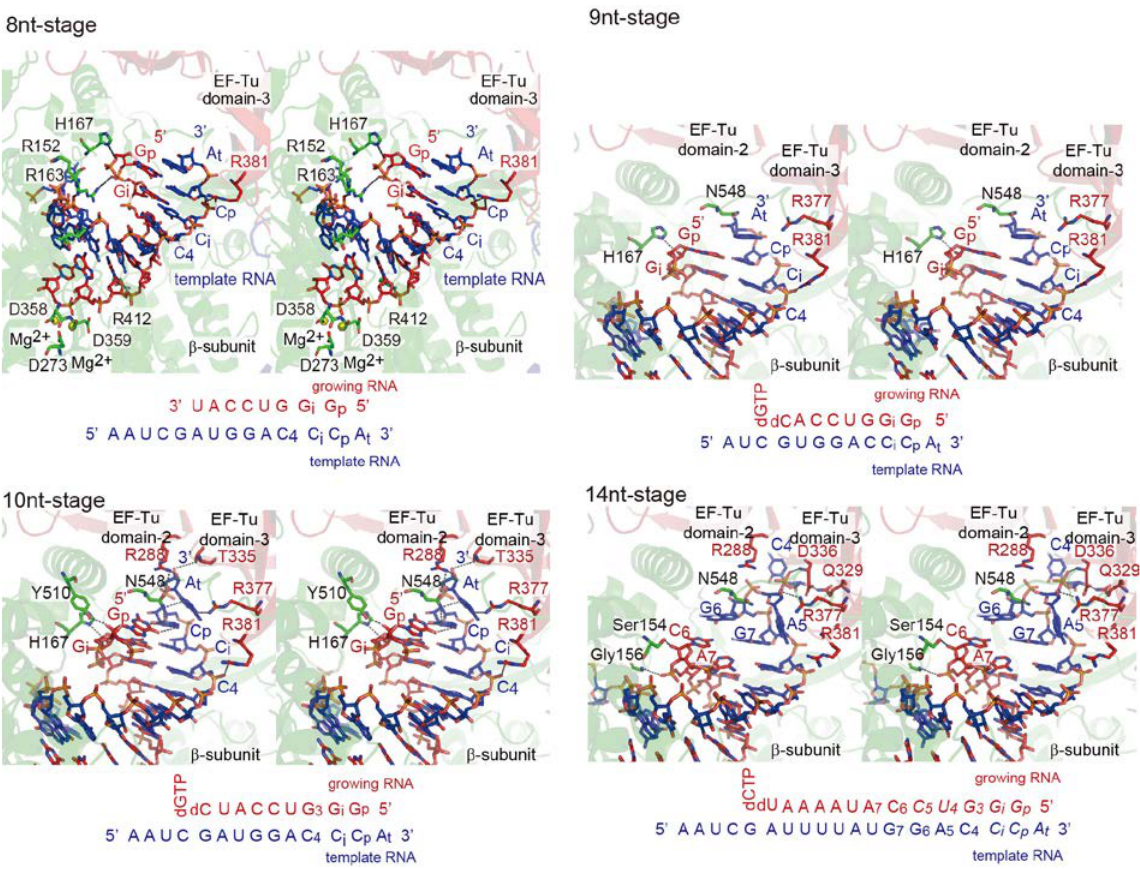
Figure 4. Structures of elongation stages. Structures representing eight, nine, ten and fourteen nucleotide-long synthesized RNAs (8nt-, 9nt-, 10nt- and 14nt-stages). Only the structures in the catalytic crevasse of core Qβ replicase are shown. The β-subunit, EF-Tu and EF-Ts are colored green, red and blue, respectively. The template and growing RNAs are depicted by blue and red stick models, respectively. The sequences of the template RNA and the growing RNA at each stage are